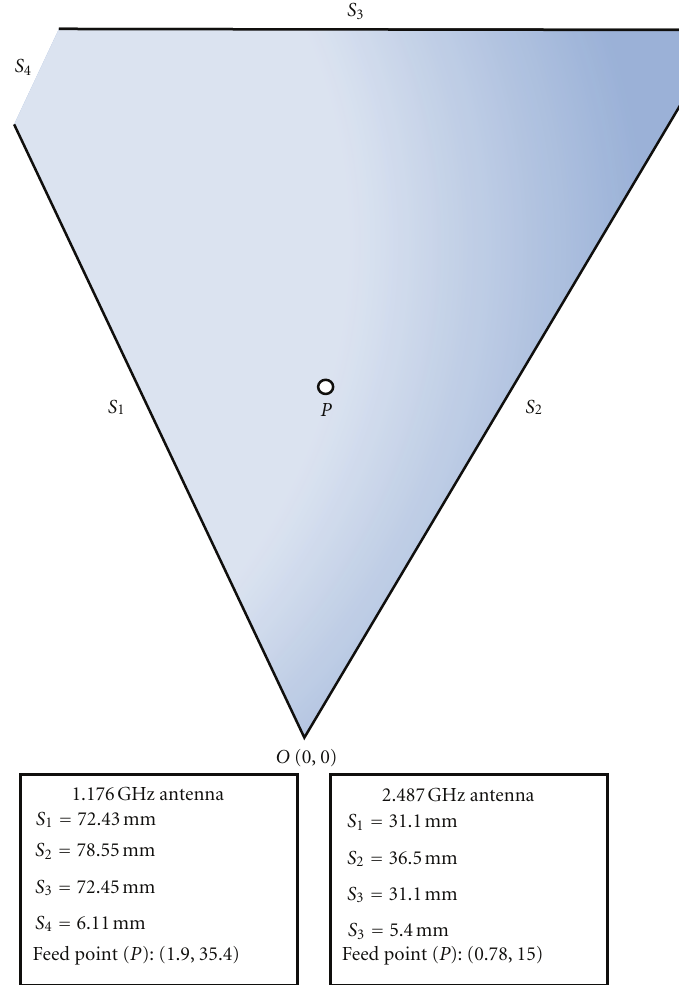
Figure 3: Layout of 1.176 GHz and 2.487 GHz